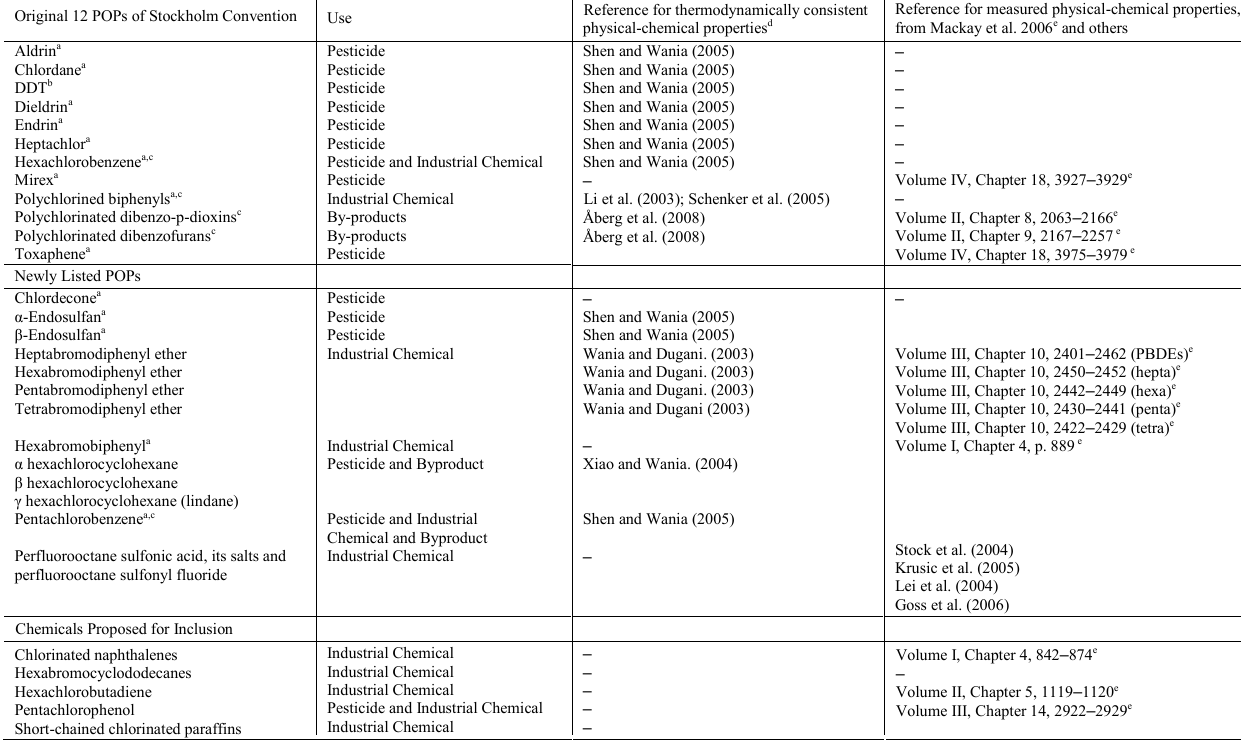
Table 1. Stockholm Convention Persistent Organic Pollutants, Uses, and References for Key Chemical Properties Relevant to the Cryosphere. Reference for measured physical-chemical properties, Original 12 POPs of Stockholm Convention Use Reference for thermodynamically consistent physical-chemical properties d from Mackay et al. 2006 e and